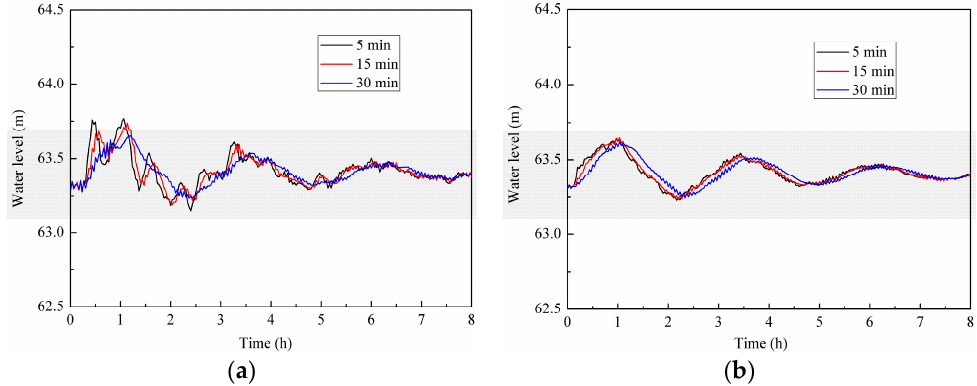
Figure 10. Water level variation process with regulation time. ( a ) Lower lock head of the ship lift; ( b ) Approach channel.